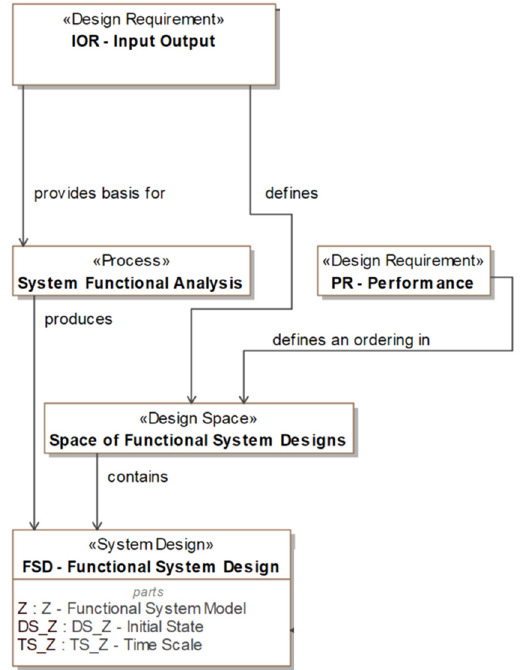
Figure 5. A description of the T3SD Functional Perspective showing that the functional design is produced on the basis of required input/output, which are ordered according to preferred performance of the designs